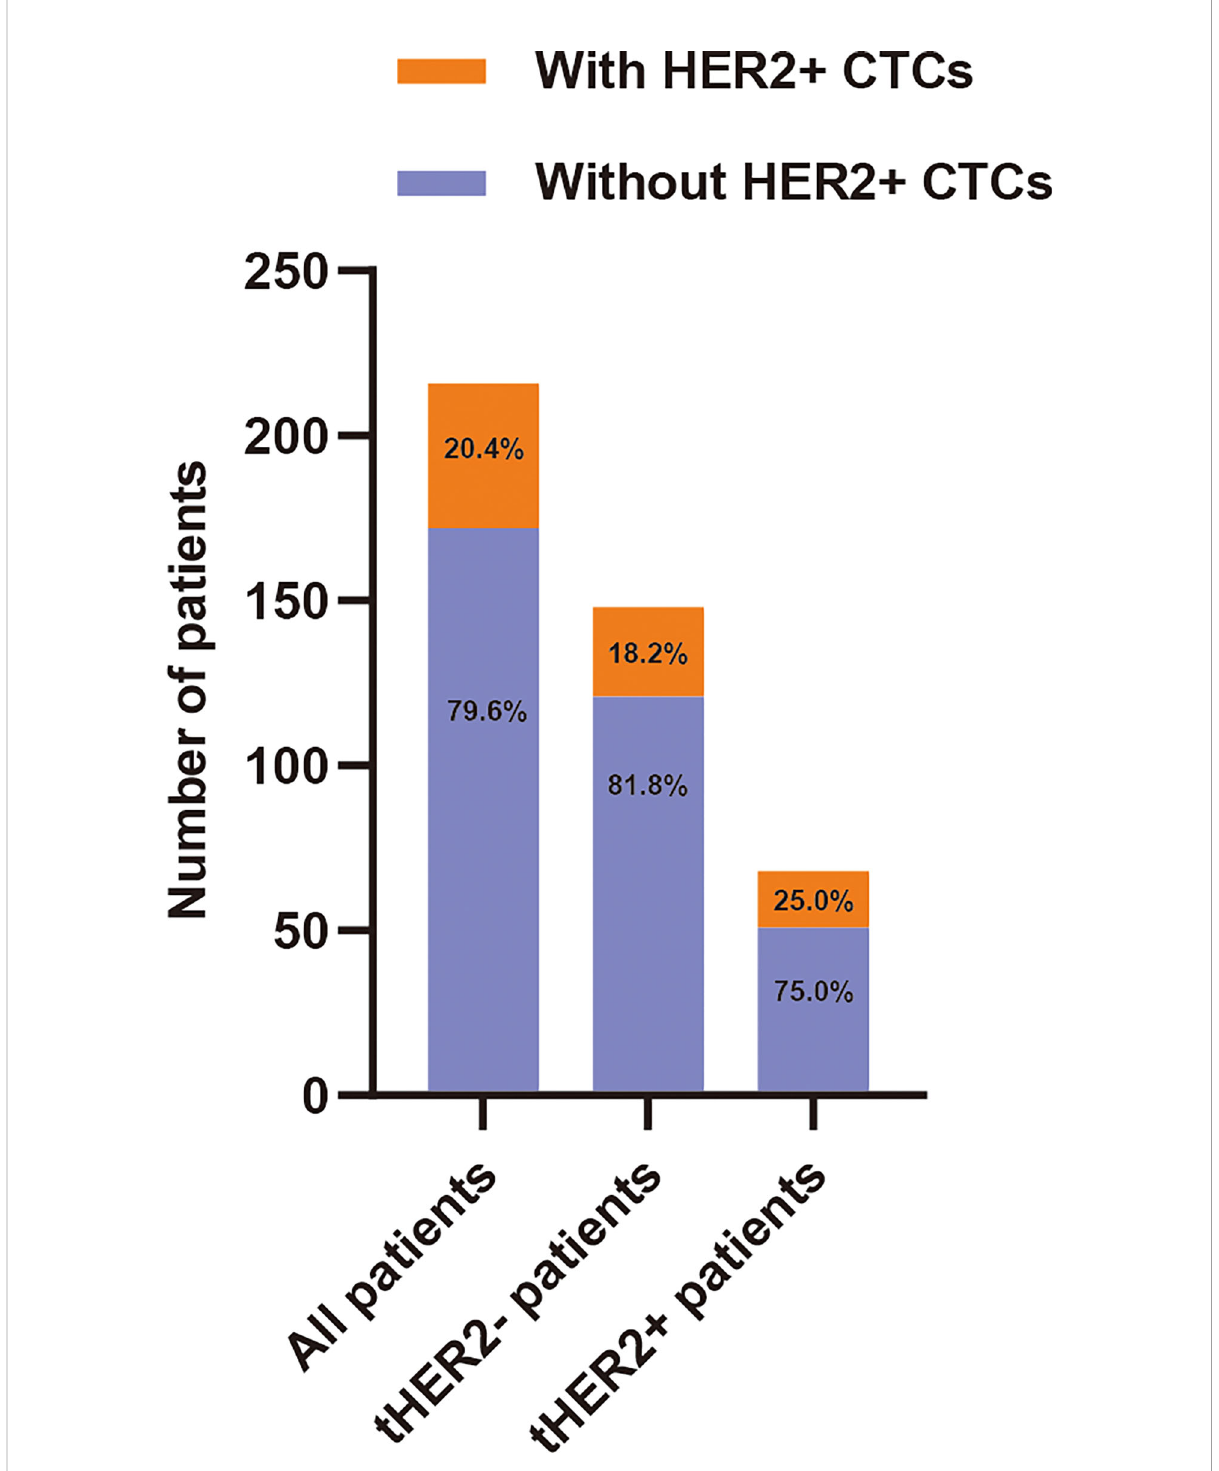
FIGURE 2 Distribution of HER2+ circulating tumor cells of patients with early breast